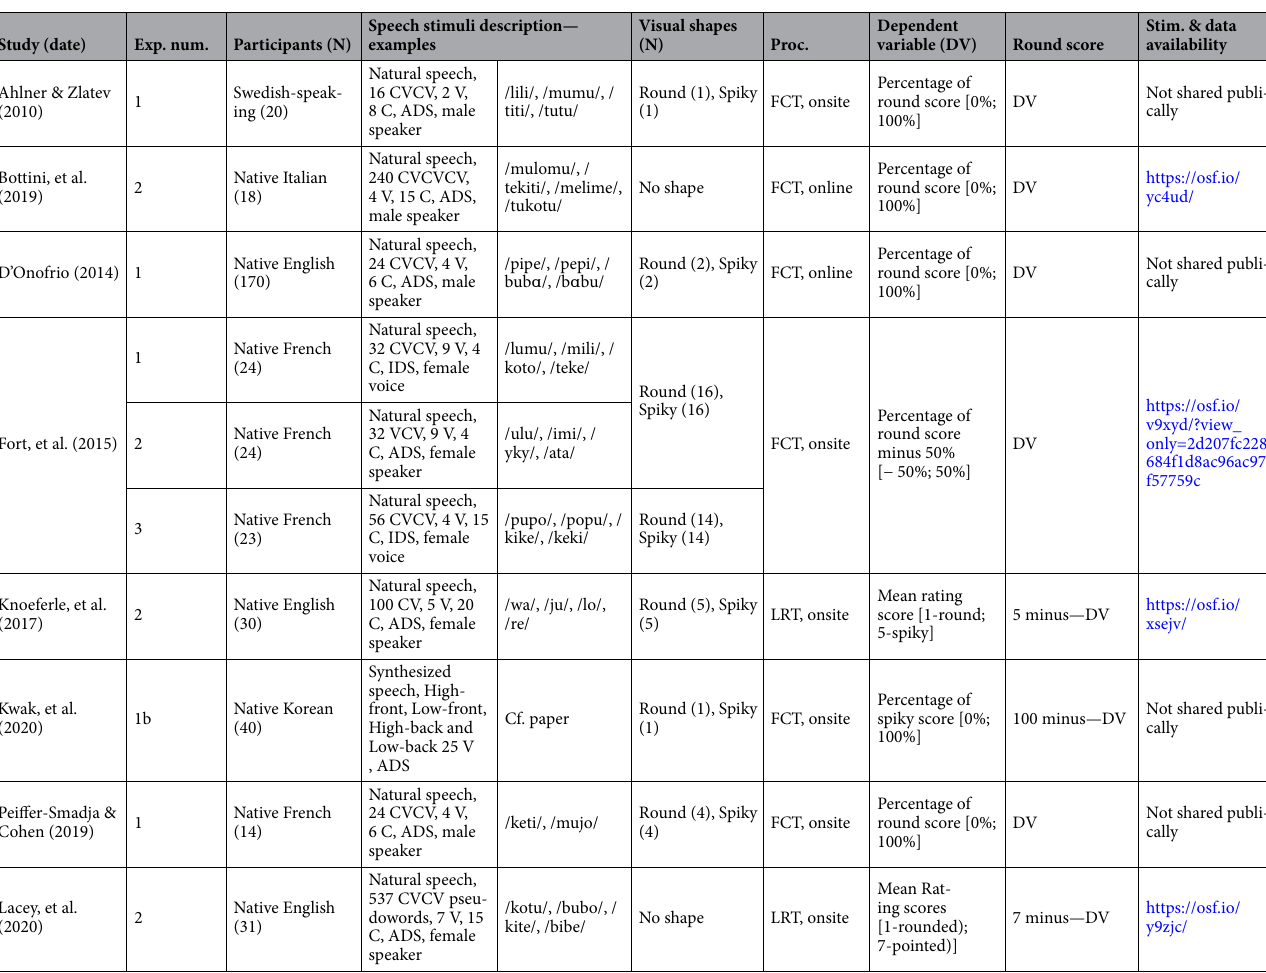
Table 2. Presentation of the data and speech stimuli of the 10 published experiments assessed in the computational phenomenological model. The experiment number matches the one from the original publication. The Experimental “Round Score” in the second last column is the one used in all simulations and analyses of the present paper. FCT forced choice task, LRT likert rating task, No Shape Participants judged how each speech stimulus sounded, DV dependent variable, Round Score assessment (averaged across participants) used in each study, ADS adult-directed-speech, IDS infant-directed-speech, Proc .